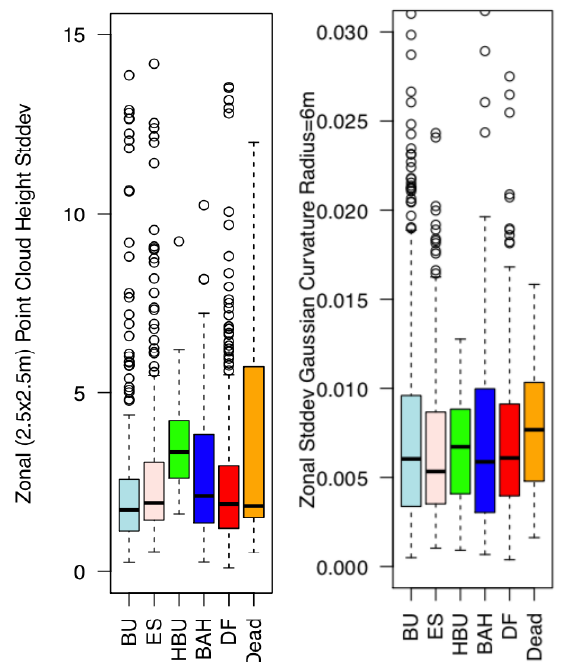
Figure 8: Local point cloud height variability SD (left) and gaussian curvature measures SD (right) investigating a radius of r=6m neighbourhood sphere. Values in 1/r (radius) using quadratic fitting method. Zonal curvature variability (SD) calculated on 2.5 m x 2.5 m crown surface regions.